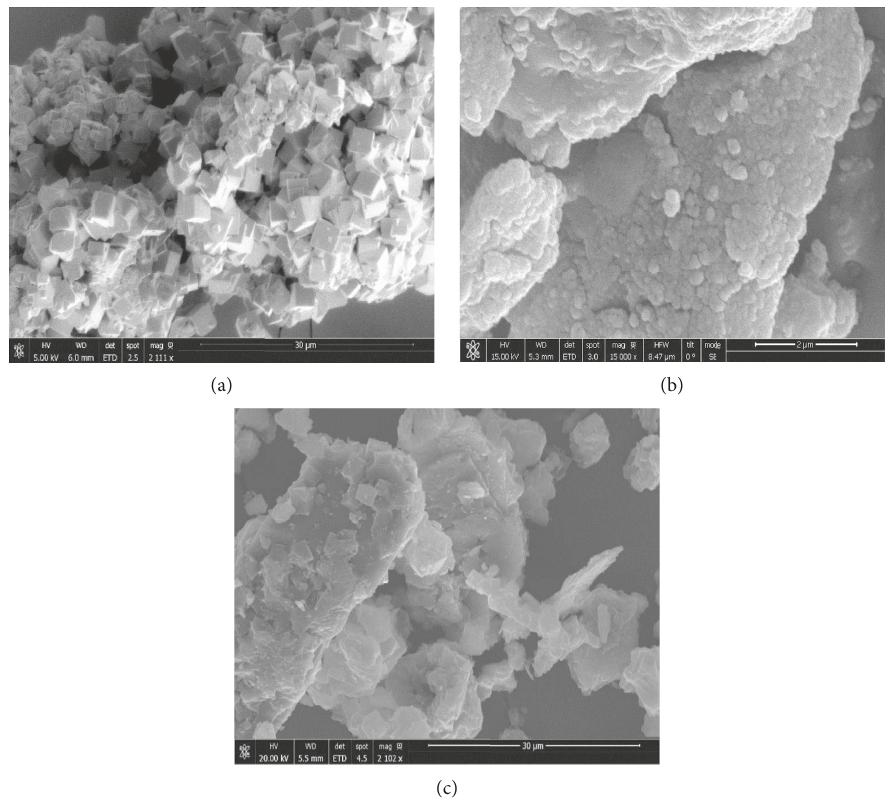
Figure 4: SEM of (a) pure zeolite, (b) Fe 3 O 4 NP, and (c) zeolite/magnetite nanocomposite (Z-Fe 3 O 4 NP).